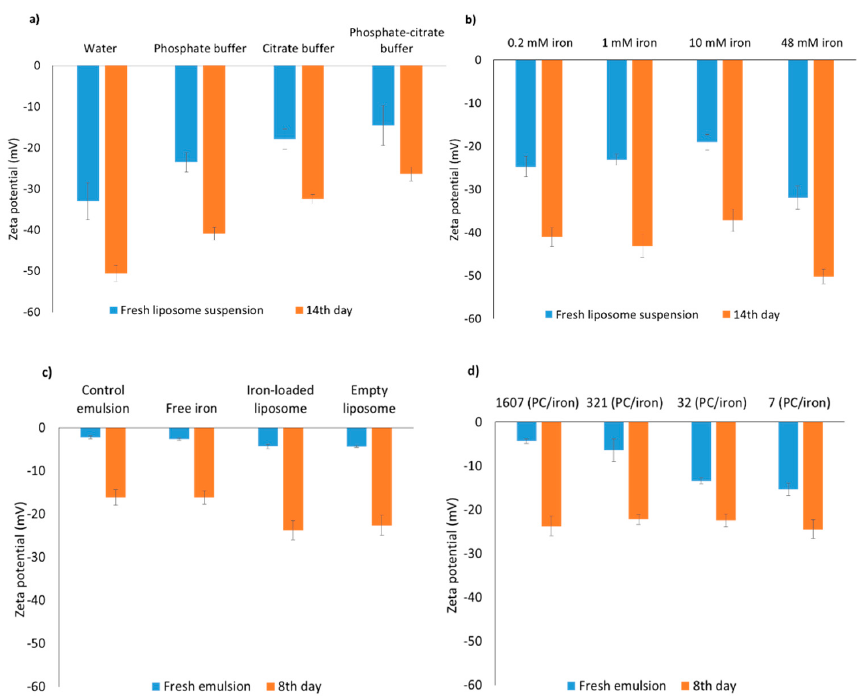
Figure 2. Zeta potential of fresh and incubated liposomes (40 °C) ( a ) in various buffers, with 0.2 mM iron; ( b ) in phosphate buffer, for various iron concentrations; and of ( c ) various reference emulsions, and ( d ) emulsions fortified with iron-loaded liposomes with various PC/iron ratio ( w / w ); please note that the bar corresponding to iron-loaded liposome in panel c, is the same as the first entry in d. All emulsions were incubated at 40 °C under slow rotative agitation; the total iron (FeSO 4 ) concentration was always 0.1 mM. Error bars represent standard deviations (n = 4).